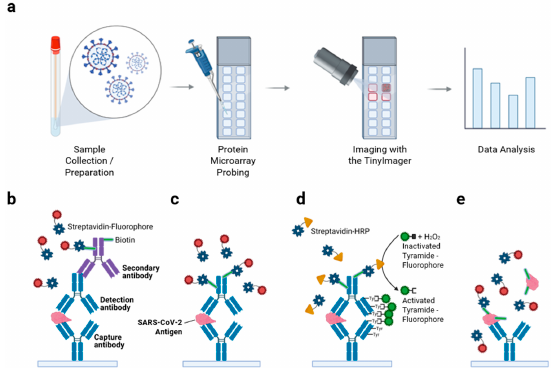
Figure 1. Antibody microarray workflow and antigen detection scheme. ( a ) An illustration to de- scribe the workflow of a protein (antibody) microarray chip is shown. Clinical samples, inactivated viruses, and recombinant viral proteins can be probed on a protein microarray chip. In this study, the microarray images were acquired by the TinyArray imager [20] unless otherwise specified. Fluores- cence data analysis was performed using ProScanArray Express software. Single antigen detection schemes used in this study are shown in ( b – d ). In ( b ), a detection antibody, biotinylated host-specific secondary antibody, and streptavidin-fluorophore conjugates were used to develop fluorescence signals. Streptavidin was illustrated in its tetramer form. Biotin molecules were illustrated as green rods. In ( c ), biotinylated detection antibodies and streptavidin-fluorophore conjugates were used to develop fluorescence signals. In ( d ), biotinylated detection antibody and streptavidin-horseradish peroxidase (HRP) conjugates, illustrated as yellow triangles, were used to perform downstream tyramide signal amplification (TSA) to amplify fluorescence signal. ( e ) For multiplexed testing of different targets, total viral proteins are biotinylated and captured by corresponding antibodies on the array. Then, streptavidin-fluorophore conjugates were probed to develop fluorescence signals. This figure was created with